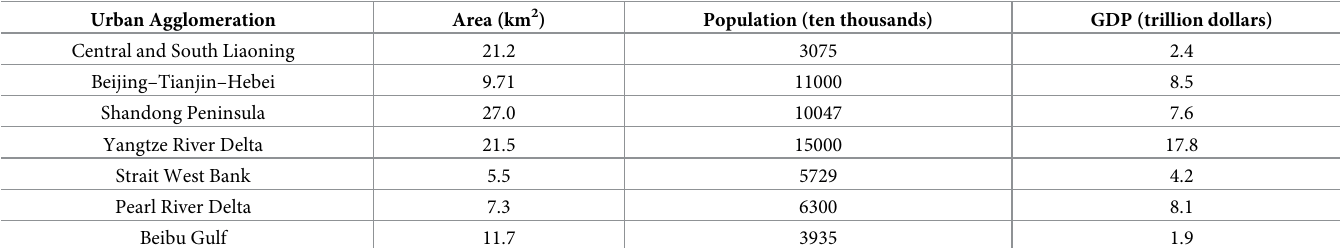
Table 1. Summary of the area, population, and contribution to GDP for China’s coastal urban agglomerations in 2017. Urban